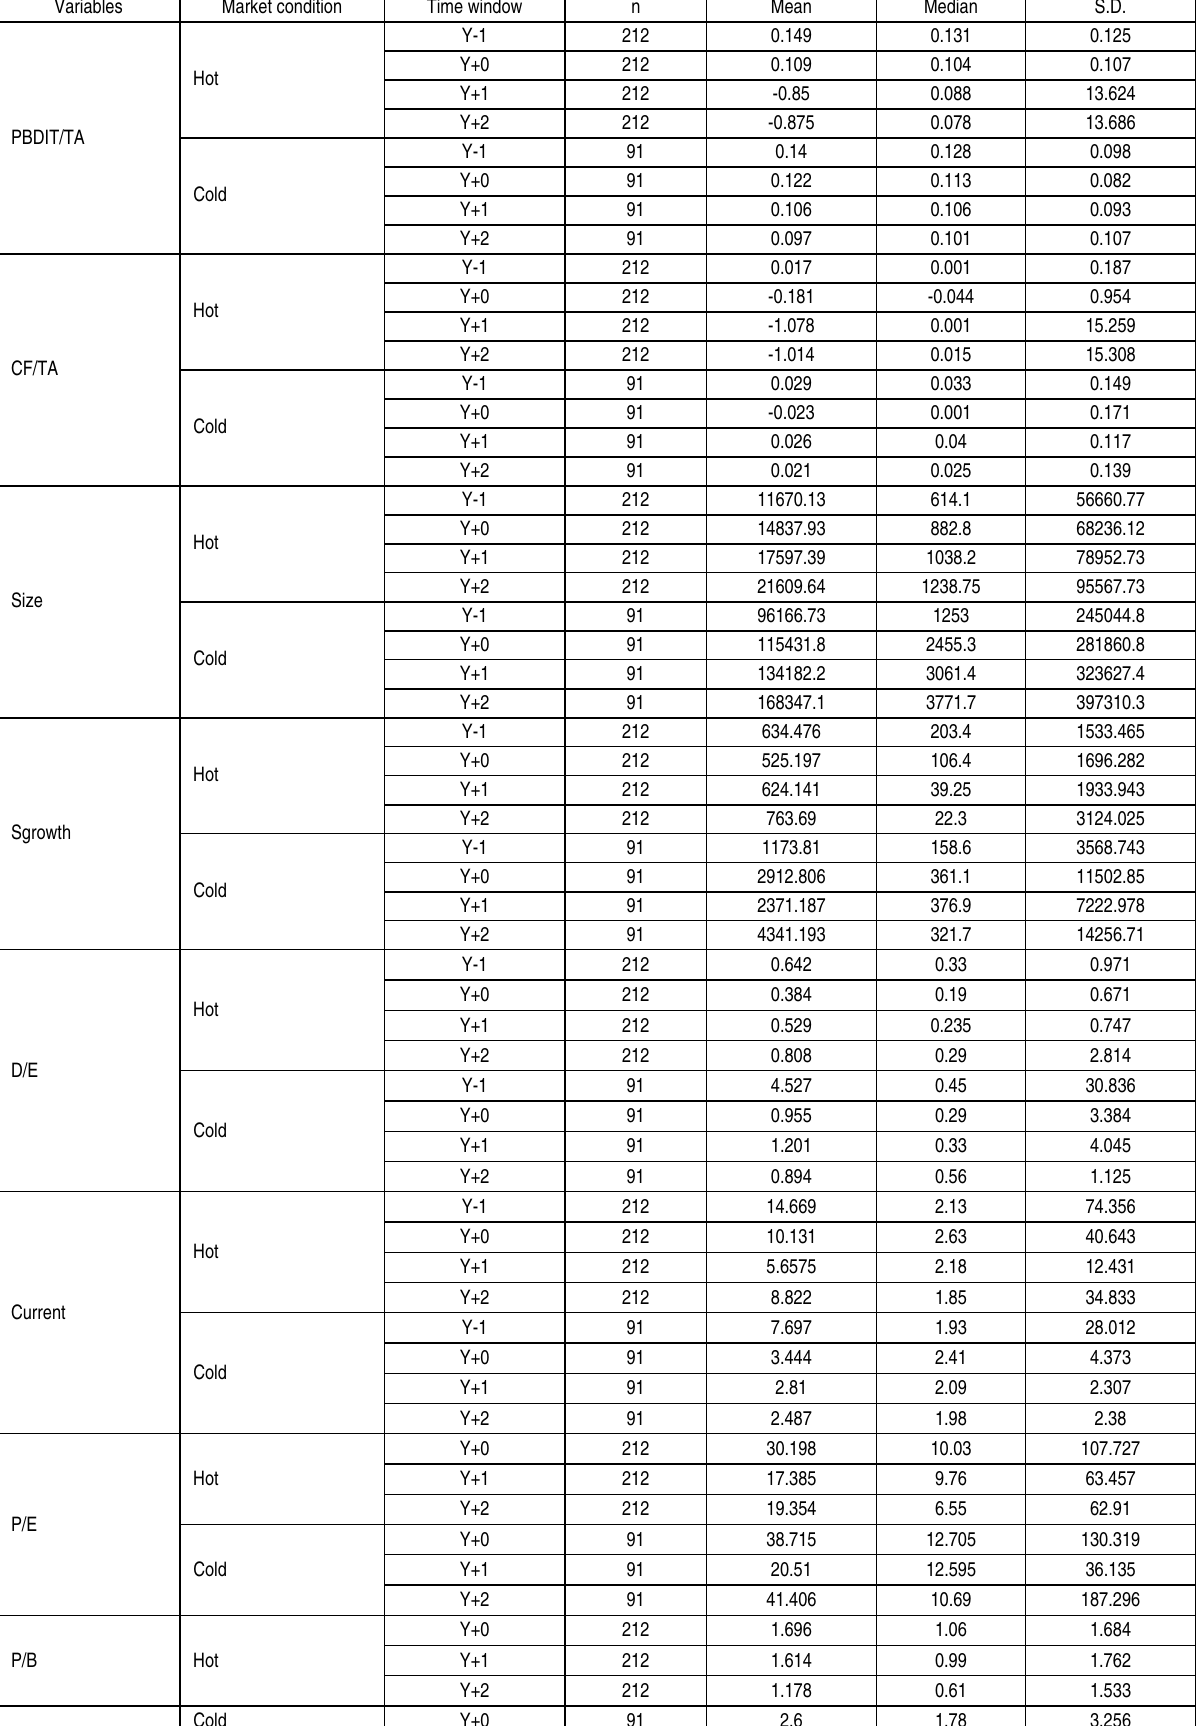
Table 3. Summary